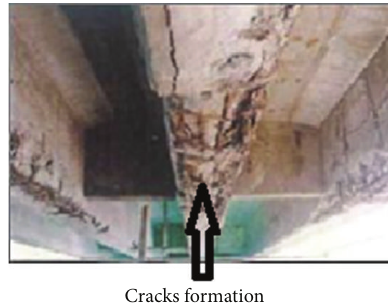
Figure 2: Cracks formation.